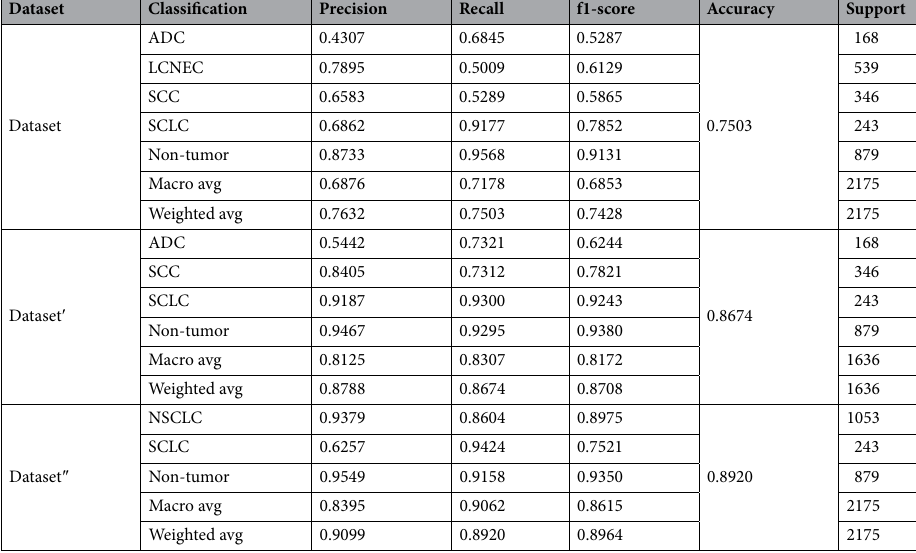
Table 4. Performance of the CNN from scratch model for test sets. ADC adenocarcinoma, LCNEC large cell neuroendocrine carcinoma, SCC squamous cell carcinoma, SCLC small cell lung cancer, Dataset ′ the dataset excluding the class LCNEC, Dataset ″ the dataset consisting of NSCLC (ADC, LCNEC, SCC), SCLC, and non- tumor, Precision the fraction of relevant instances among the retrieved instances, Recall the fraction of relevant instances that were retrieved, f1-score a measure of test set’s accuracy and the harmonic mean of the precision and recall, Support number of test set for each label and total, weighted average averaging the support-weighted mean per label, macro average the arithmetic mean of individual classes’ precision, recall, and